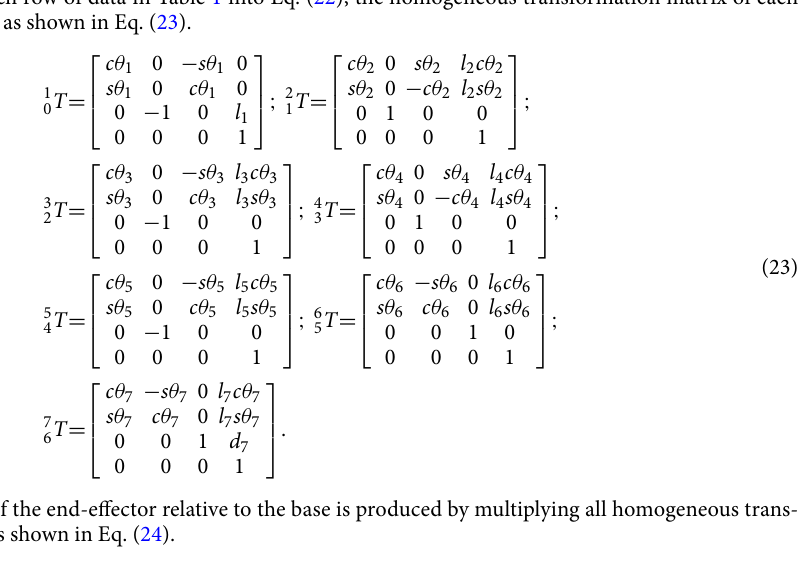
where T End - Effector represents the end-effector’s homogeneous transformation matrix with regard to the base coordinate system. When the value of a given joint variable is in Eq. (24), the alternative representation of T End - Effector can be written as Eq. (25).